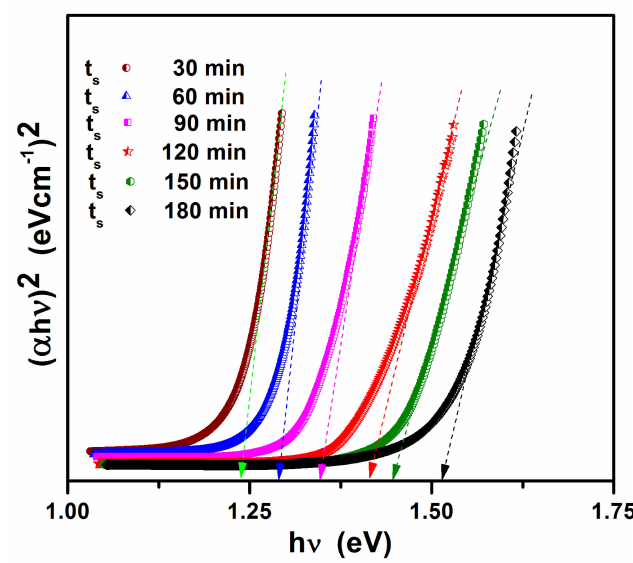
Figure 8. Plots of ( α h ν ) 2 versus h ν for SnS